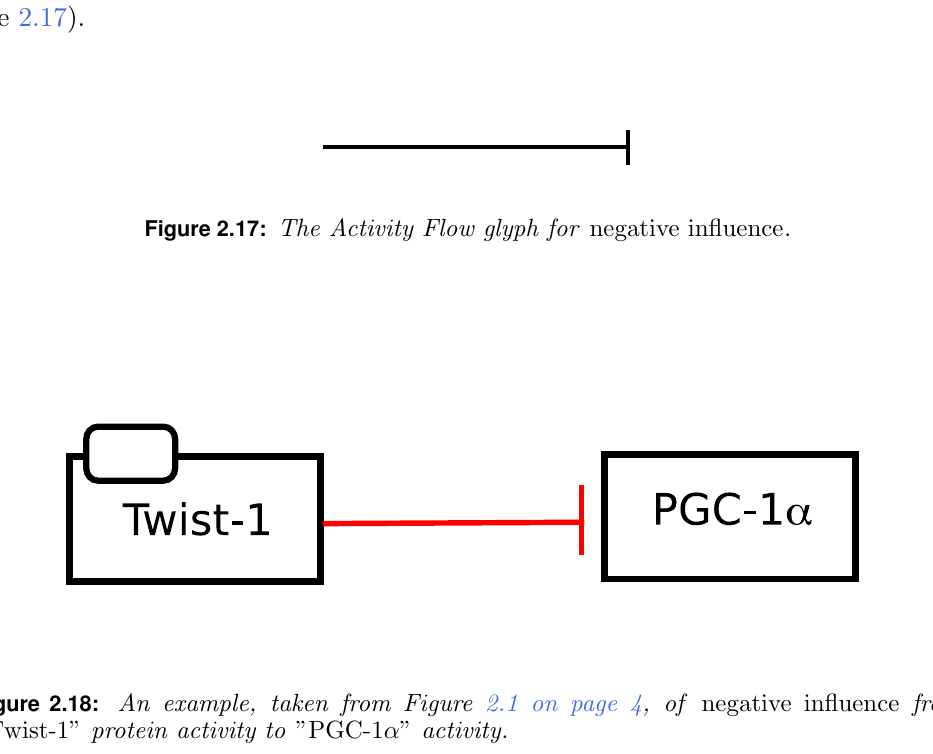
Figure 2.18: An example, taken from Figure 2.1 on page 4, of negative influence from ”Twist-1” protein activity to ”PGC-1 α ”